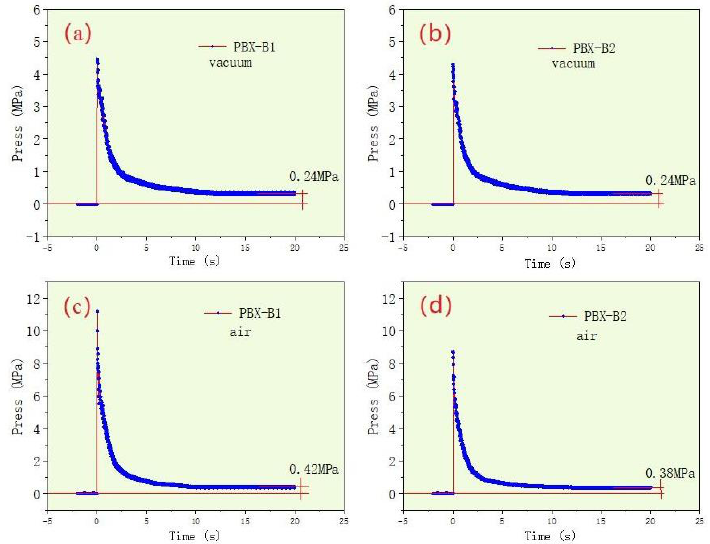
Figure 4. The pressure–time curves of PBX-B1 and PBX-B2 under vacuum ( a , b ) and air ( c , d ) condi- tions, respectively.